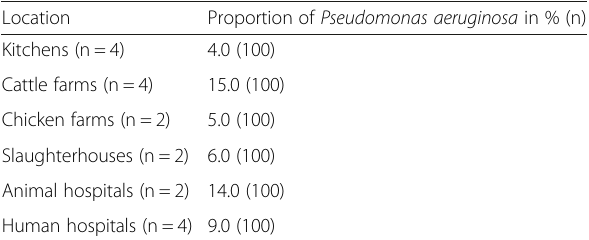
Table 1 Recovery frequencies of Pseudomonas aeruginosa from houseflies captured at different locations in Shahrekord and Isfahan provinces of Iran